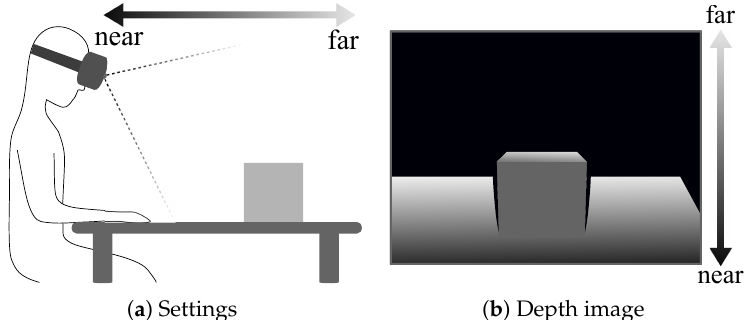
Figure 4. Composition of depths in depth images captured using a head-mounted display (HMD)- mounted depth sensor. ( a ) Settings; ( b ) depth